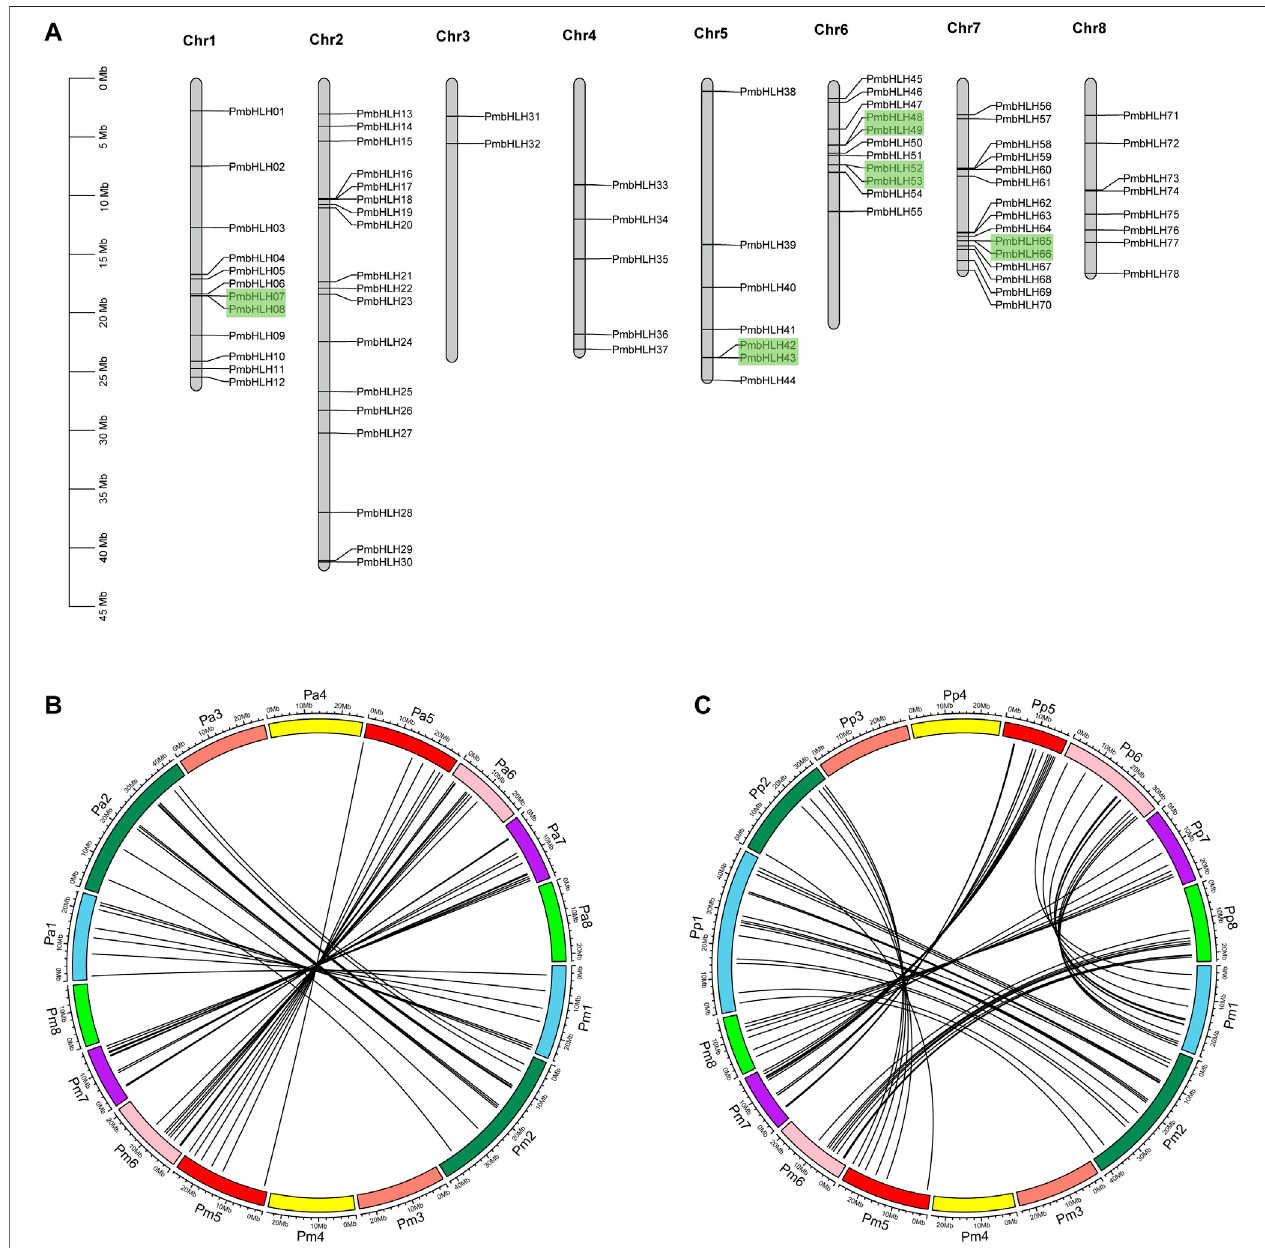
FIGURE 4 | Chromosomal mapping of PmbHLHs and synteny analysis in P. mume (Pm),P. avium (Pa) and P. persica (Pp). (A) Chromosomal distribution of PmbHLH genes. 78 PmbHLH genes were unevenly mapped on eight chromosomes. Tandem duplicated gene pairs are displayed with green blocks. (B) Synteny analysis in P. mume and P. avium . The same color blocks represent the same chromosome label in P. mume and P. avium . Black lines mean orthologous bHLH in P. mume and P. avium . (C) Synteny analysis in P. persica and P. mume . The same color blocks represent the same chromosome label in P. persica and P. mume . Black lines mean orthologous bHLH in P. persica and P. mume